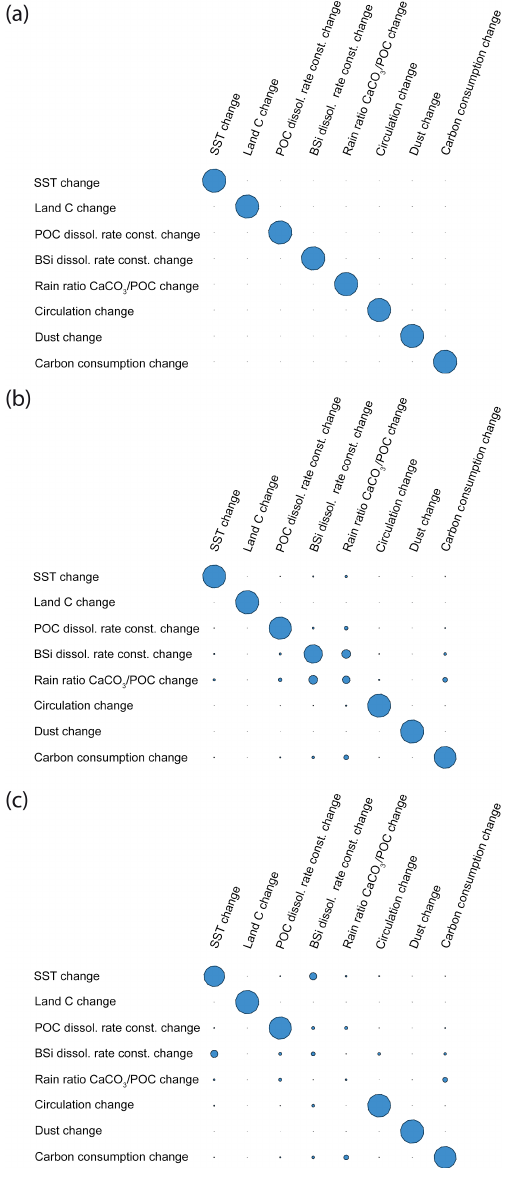
Figure 9. Resolution matrices for the full rank (rank 8) (a) , rank 7 (b) , and rank 6 (c) solutions. The CaCO 3 :C org rain ratio varia- tions can no longer determined for a realistic length of the solution vector of parameter variations.